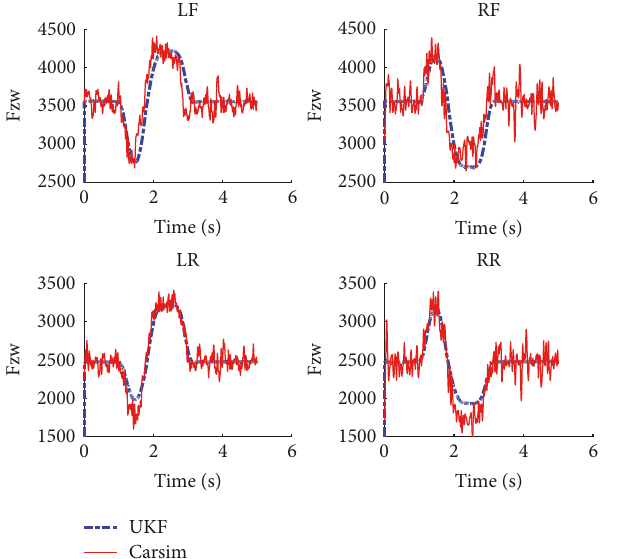
Figure 10: Estimation results comparison of sideslip angle.